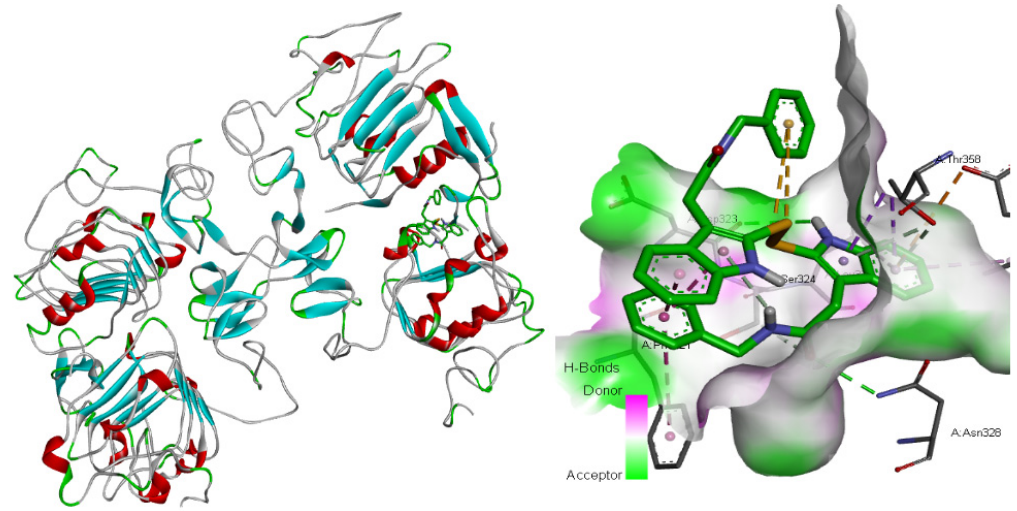
Figure 3. A 3D molecular diagram of the top three compounds.